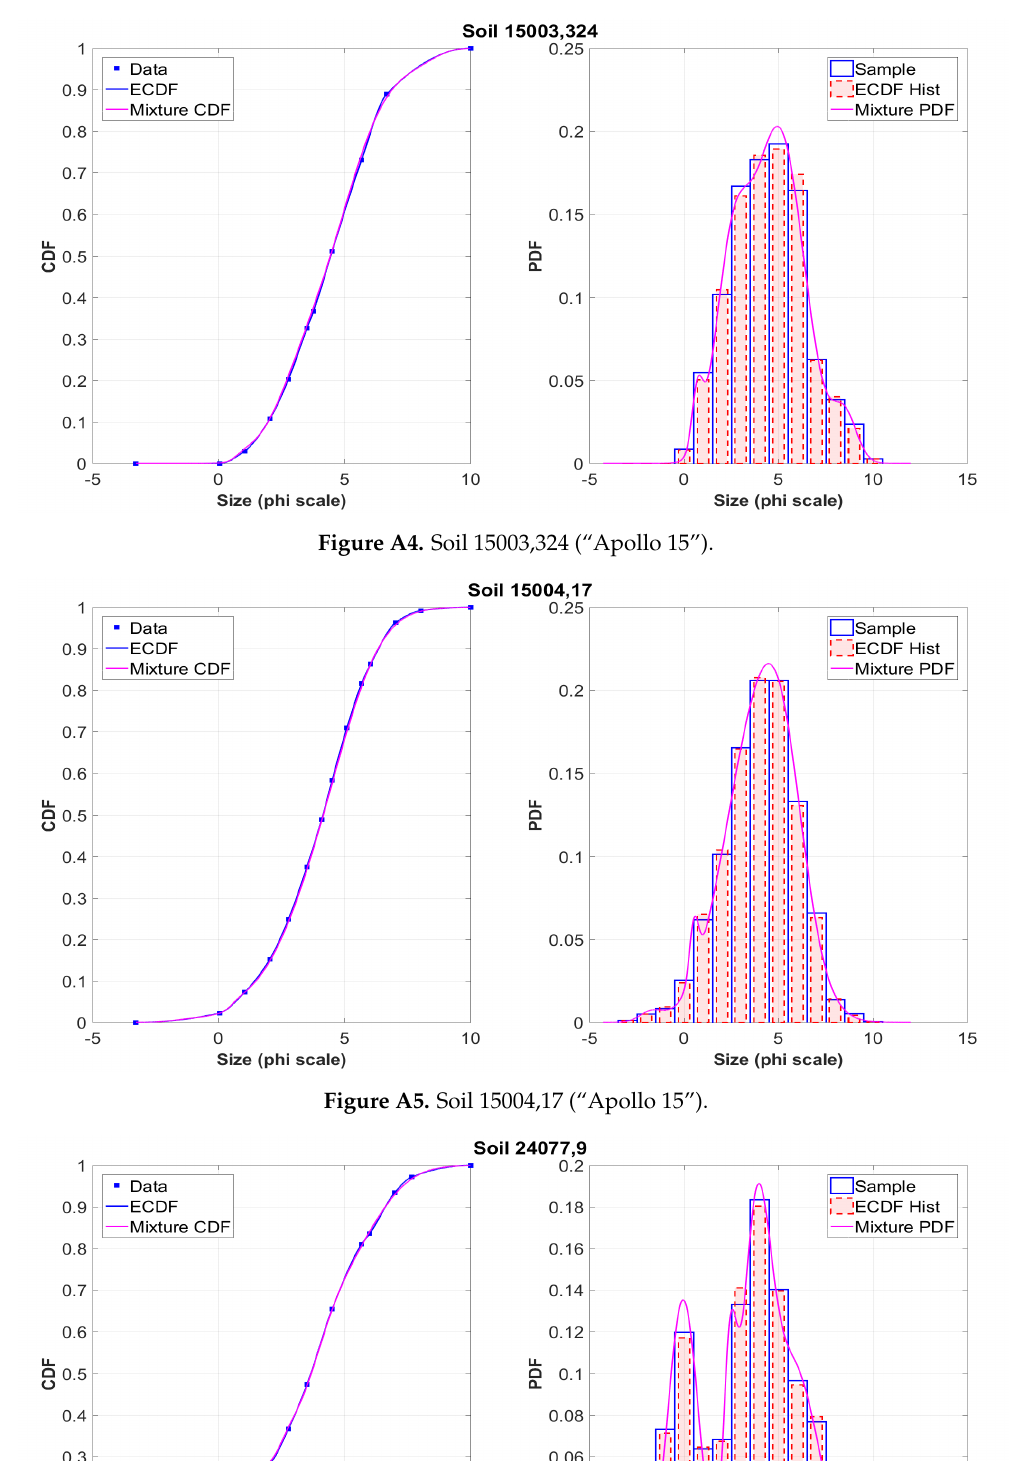
Figure A6. Soil 24077,9 (“Luna